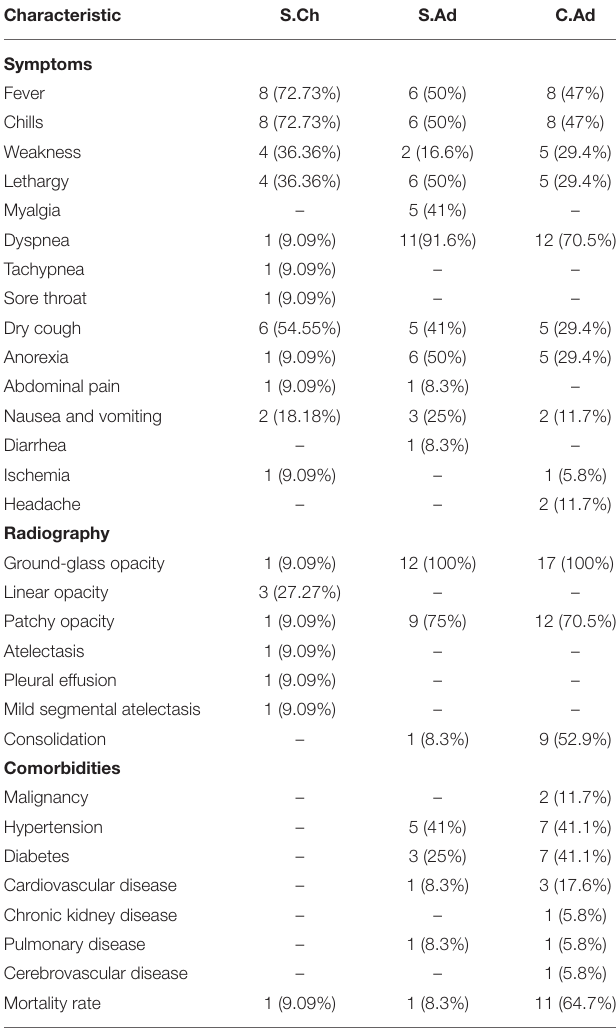
TABLE 1 | Clinical characteristics of COVID-19